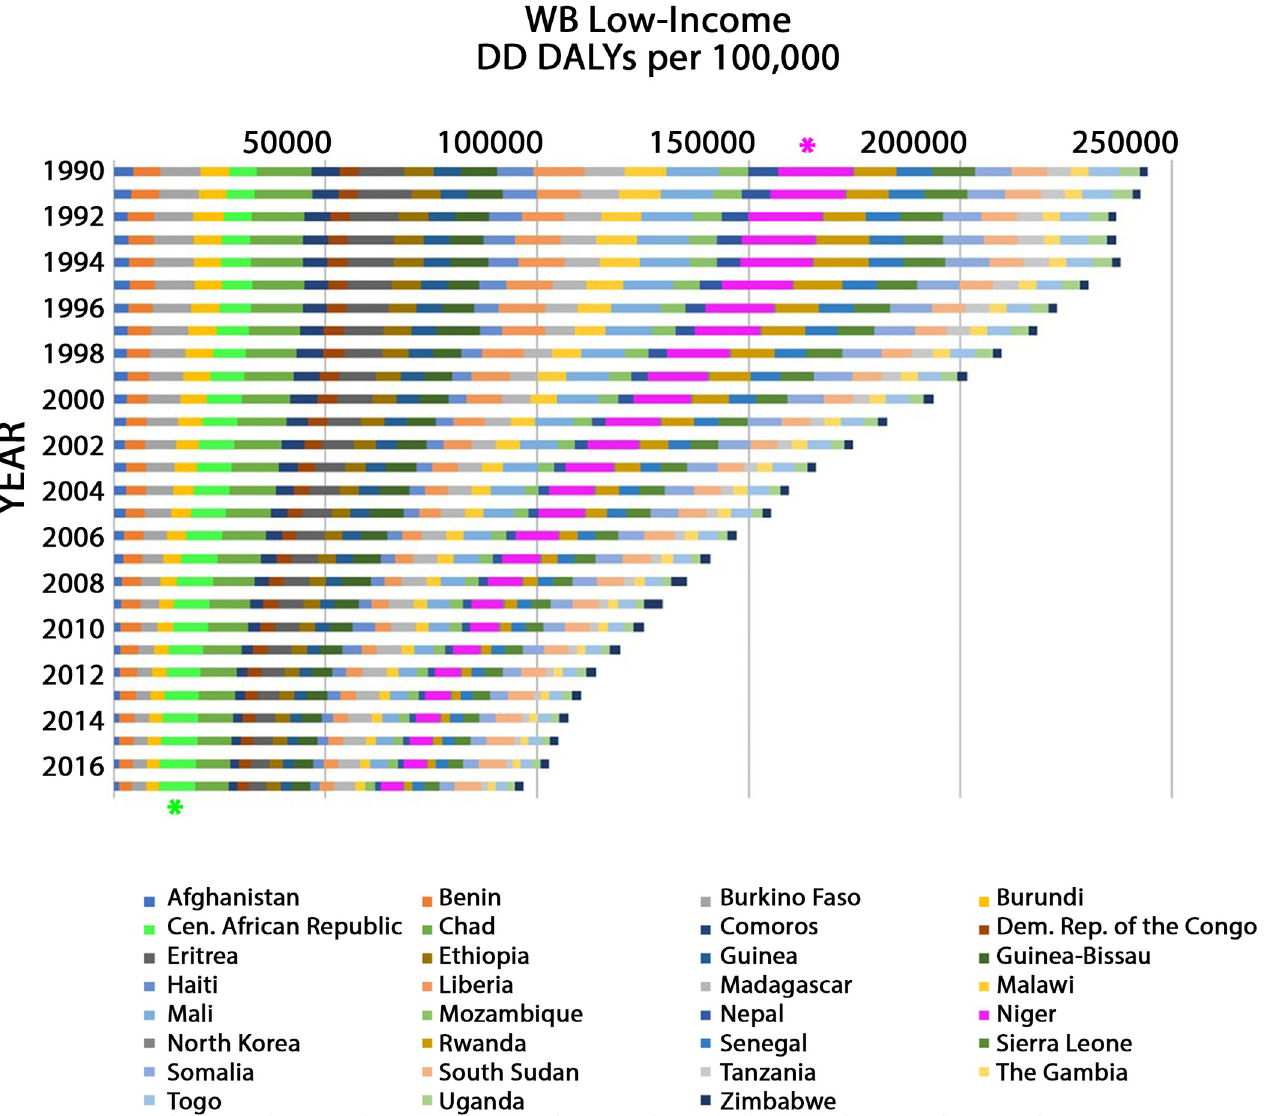
Fig 1. Age-standardized DD DALY rates from 1990 to 2017 in WB low-income constituents. For each year (bar), the total DD DALY rate represents the sum of individual country DD DALY rates given in alphabetical order from left to right as follows: Afghanistan, Benin, Burkina Faso, Burundi, Central (Cen.) African Republic, Chad, Comoros, Democratic (Dem.) Republic (Rep.) of Congo, Eritrea, Ethiopia, Guinea, Guinea-Bissau, Haiti, Liberia, Madagascar, Malawi, Mali, Mozambique, Nepal, Niger, North Korea, Rwanda, Senegal, Sierra Leone, Somalia, South Sudan, Tanzania, The Gambia, Togo, Uganda and Zimbabwe. Asterisks identify the countries with the highest number of DD DALYs per 100,000 in 1990 (Niger; magenta asterisk) or in 2017 (Central African Republic; green asterisk). per 100,000 were highest in Central African Republic with an estimate of 8,590.04 (95% UI: 5,449.51–12,230.82) (green asterisk, Fig 1). In fact, DD DALY rates for Central African Republic, in 2017 (8,590.04), were 34.21% greater than that in 1990 (6,400.68). For all years from 1990–2017 North Korea had the lowest number of DD DALYs per 100,000 (Fig 1). Unsurprisingly, there were substantially more total DD DALYs per 100,000 in WB low-income regions (Fig 1) than in high-income regions (Fig 2) with a ratio of 34.9:1 in 1990 and 14.8:1 in 2017.